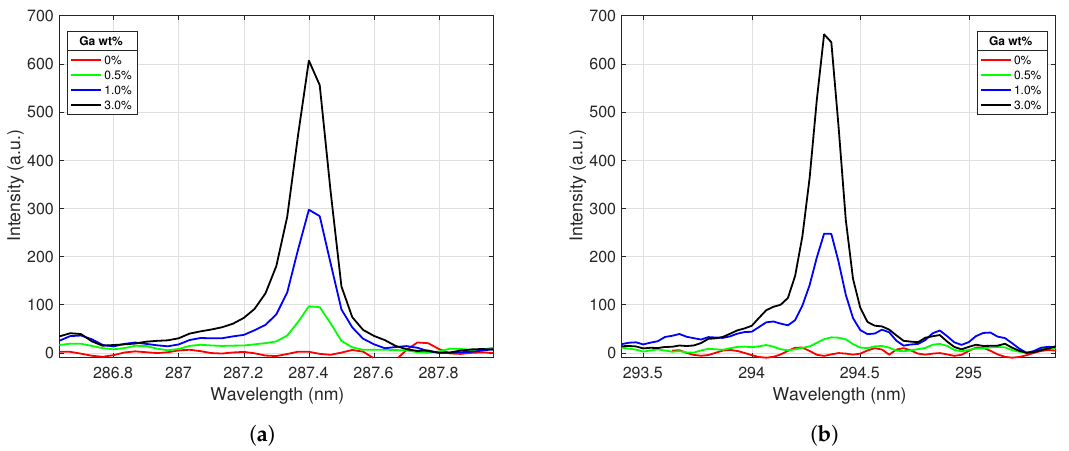
Figure 3. Ga I emission peaks centered at ( a ) 287.4 nm and ( b ) 294.4 nm. The peak intensities increase as the gallium concentration in the alloy increases.